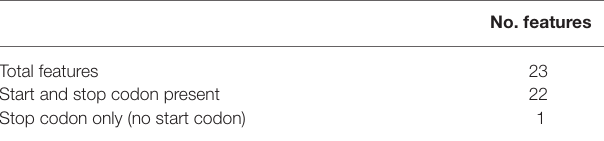
TABLE 8 | Sequence feature summary of the new gene